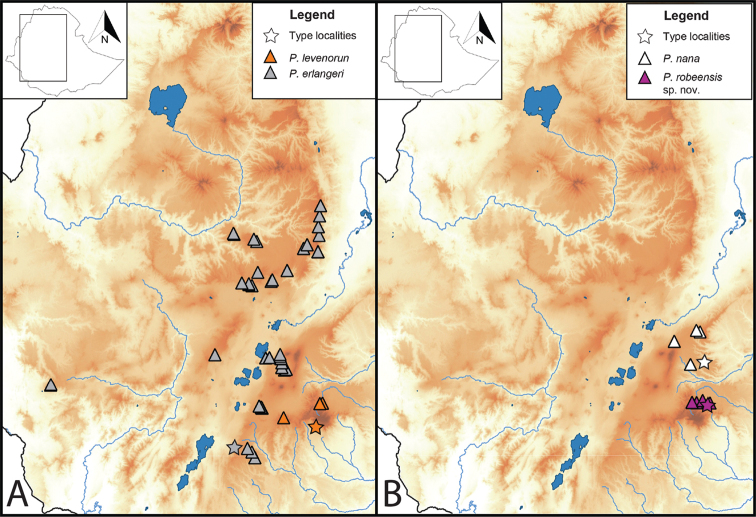
Distribution maps of members of the erlangeri species group APtychadena
erlangerisensu stricto (gray triangles) and P.
levenorum (orange triangles) BPtychadena
robeensis sp. nov. (purple triangles) and P.
nana (white triangles). Type localities for each species are indicated with a star.